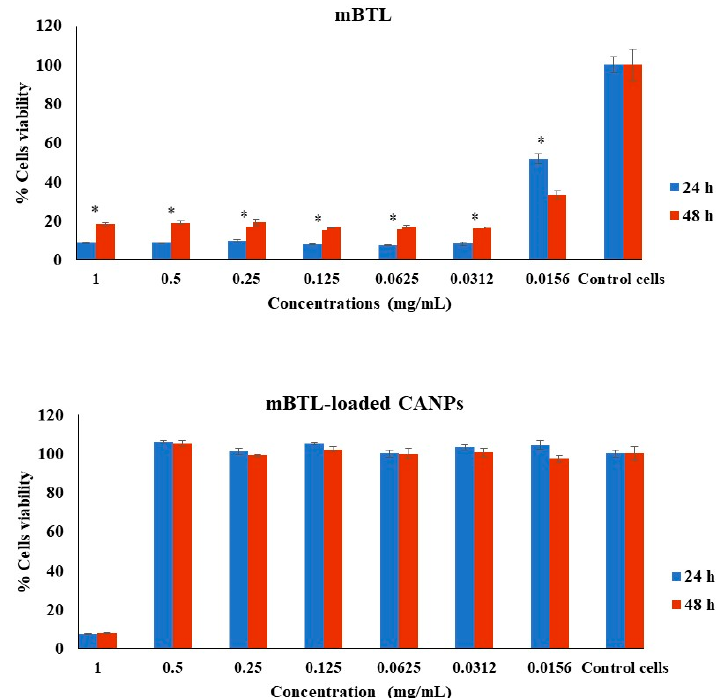
Figure 5. Effect of mBTL-loaded CANPs on the viability of A549 cells. The effects of mBTL and mBTL-loaded CANPs on cell viability were assessed after 24 h and 48 h. The untreated cells (control cells) were normalized to 100% viable, and the treated cells were the percentages of viable cells (treated cells) compared to the control. The data are presented as the mean ± SD of triplicate experiments. * p < 0.05 in Student’s t-test relative to the untreated control cells.